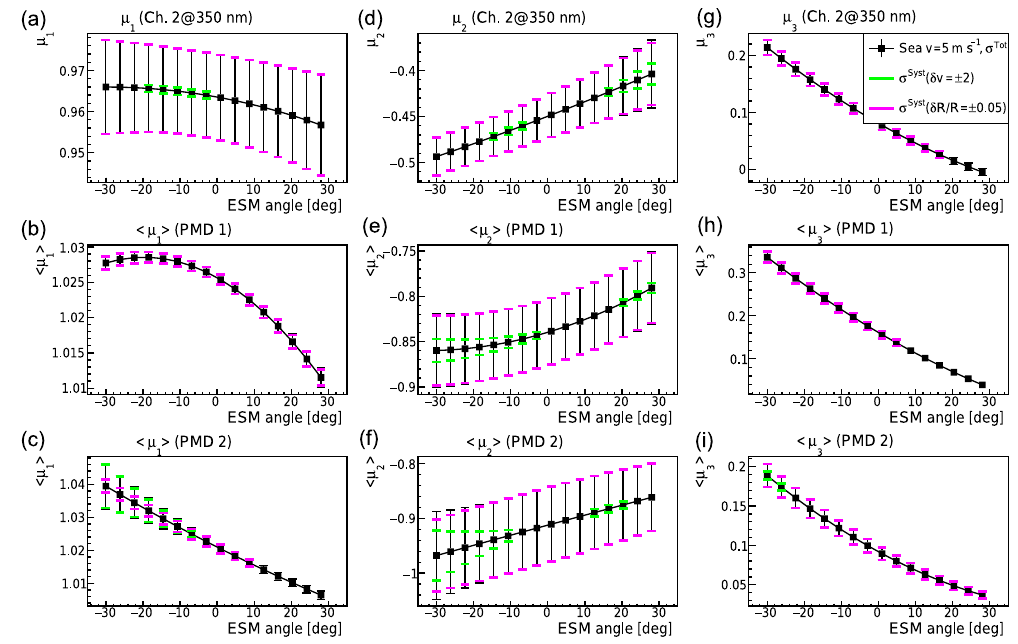
Figure 8. Final results for end-to-end MMEs vs. ESM angle for nadir over ocean in 2004 from the extrapolation method. Rows: (a, d, g) channel 2 feature, (b, e, h) PMD 1, (c, f, i) PMD 2; columns: (a, b, c) (cid:104) µ 1 (cid:105) , (d, e, f) (cid:104) µ P results with total errors; magenta and green error bars indicate the contribution from each class of systematic errors.